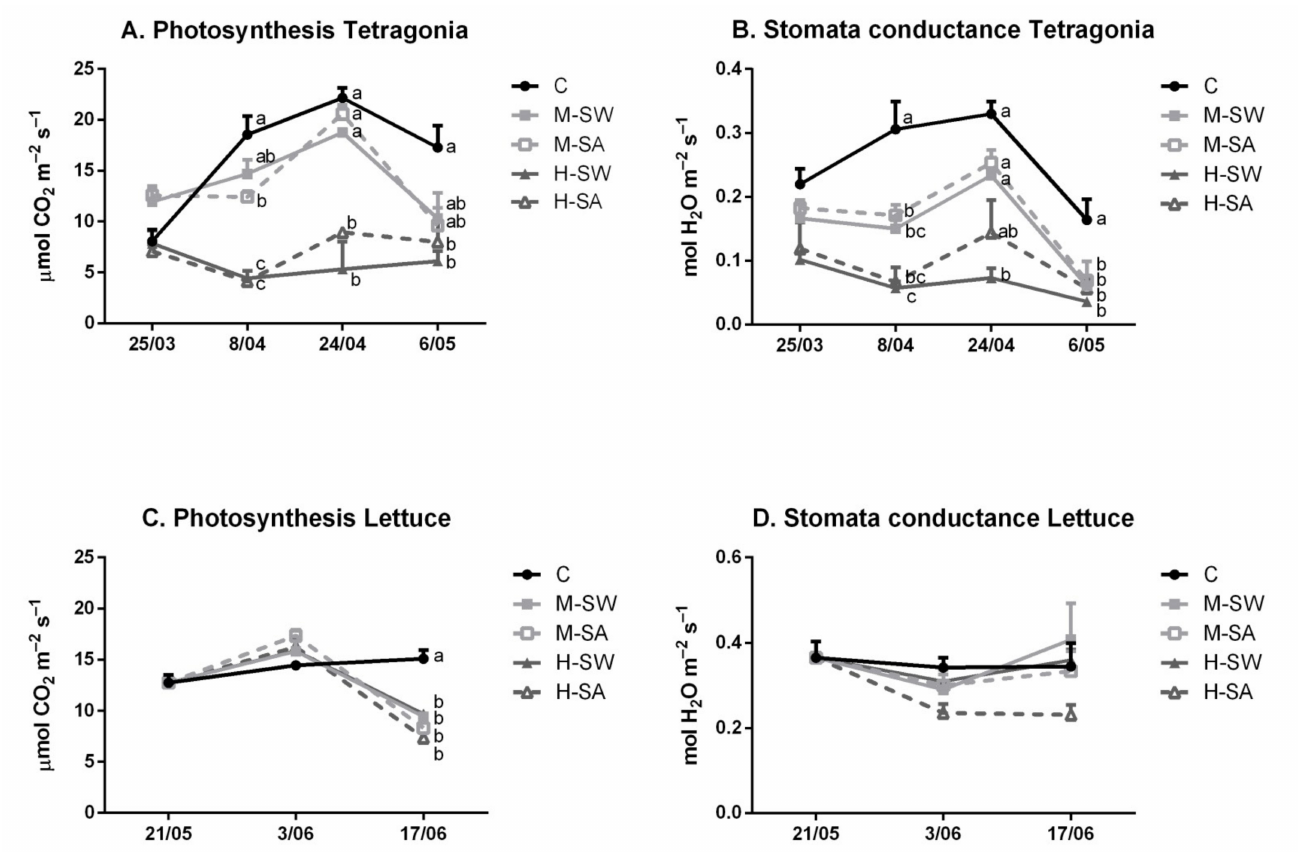
Figure 4. Photosynthetic rate ( A , C ) and stomata conductance ( B , D ) of the tested species. Values are means ( n = 4) ± SEM measured during the crop cycles. Different letters indicate significant differences at the same recording day assessed at p < 0.05 (Tukey’s test).